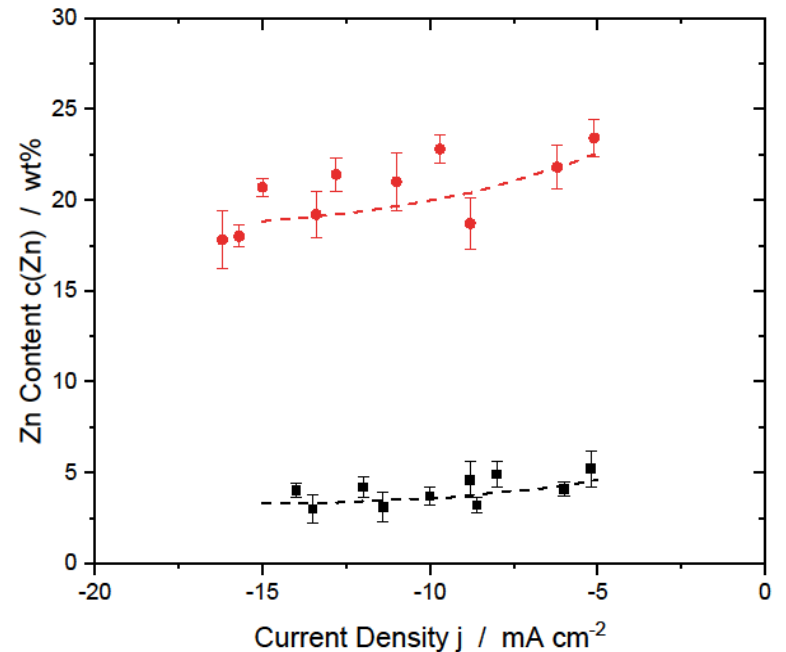
Figure 4. Zn content of the AlZn deposits (EDS) vs. current density for [EMIm]Al 2 Cl 7 –10Zn ( ■ ) and [EMIm]Al 2 Cl 7 –50Zn (●). The dashed lines are just for eye-guidance and have no physical meaning. If the deposits remain in the electrolyte at OCP, the surface takes a grayish color com- parable to the Zn-rich sample in Figure 3 (left), indicating cementation of Zn according to Equation (2).